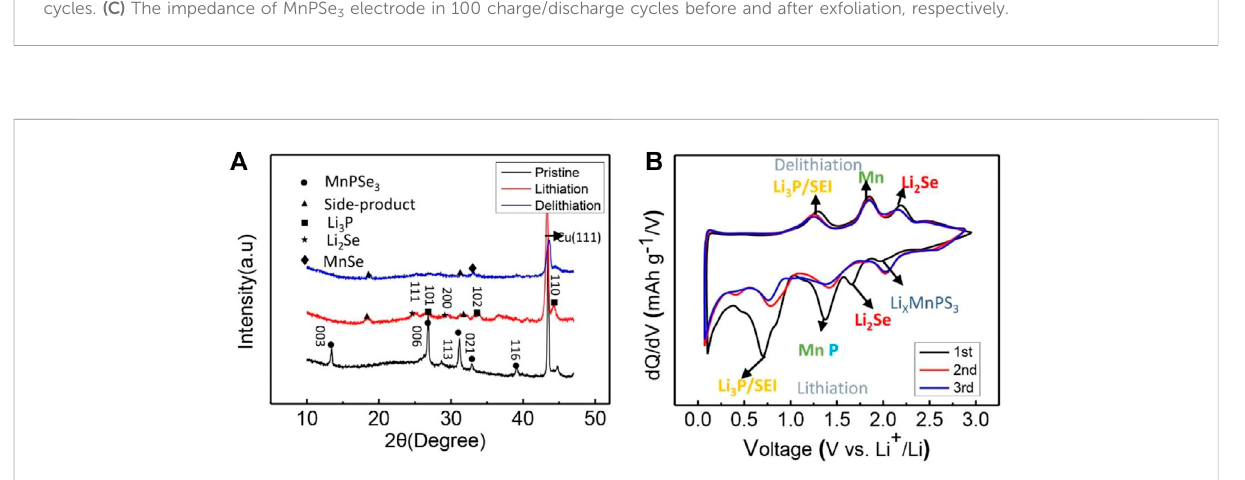
FIGURE 5 Phase characterization of MnPSe 3 electrode in lithiation/delithiation. (A) The ex-situ XRD patterns of MnPSe 3 electrodes for the fi rst lithiation/ delithiation. (B) The differential capacity curves of the MnPSe 3 electrode in the initial three